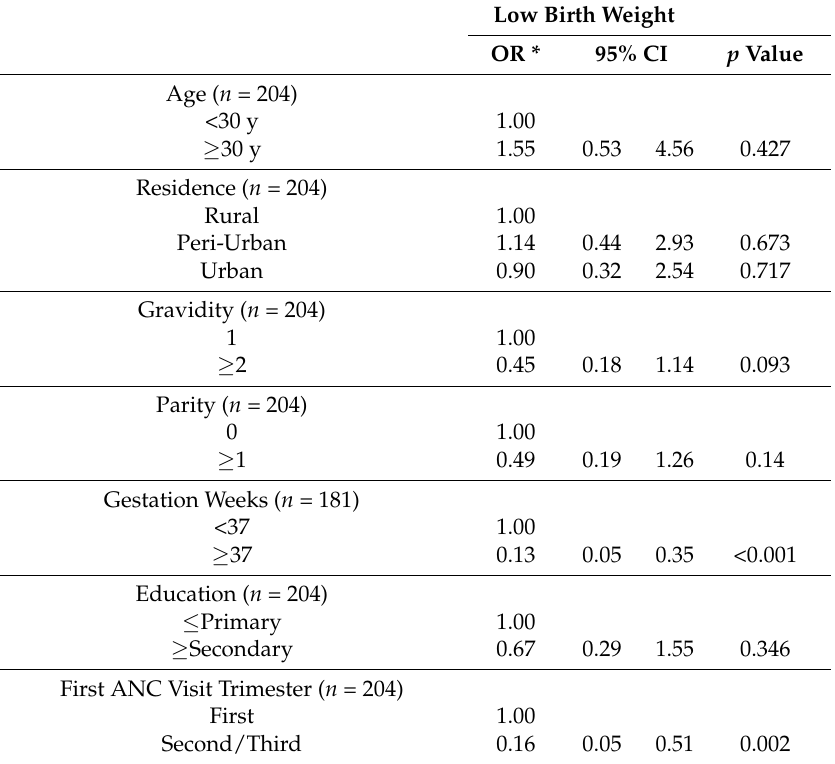
Table 4. Multivariable odds ratios (OR) and 95% confidence intervals (CIs) of low birth weight by its risk